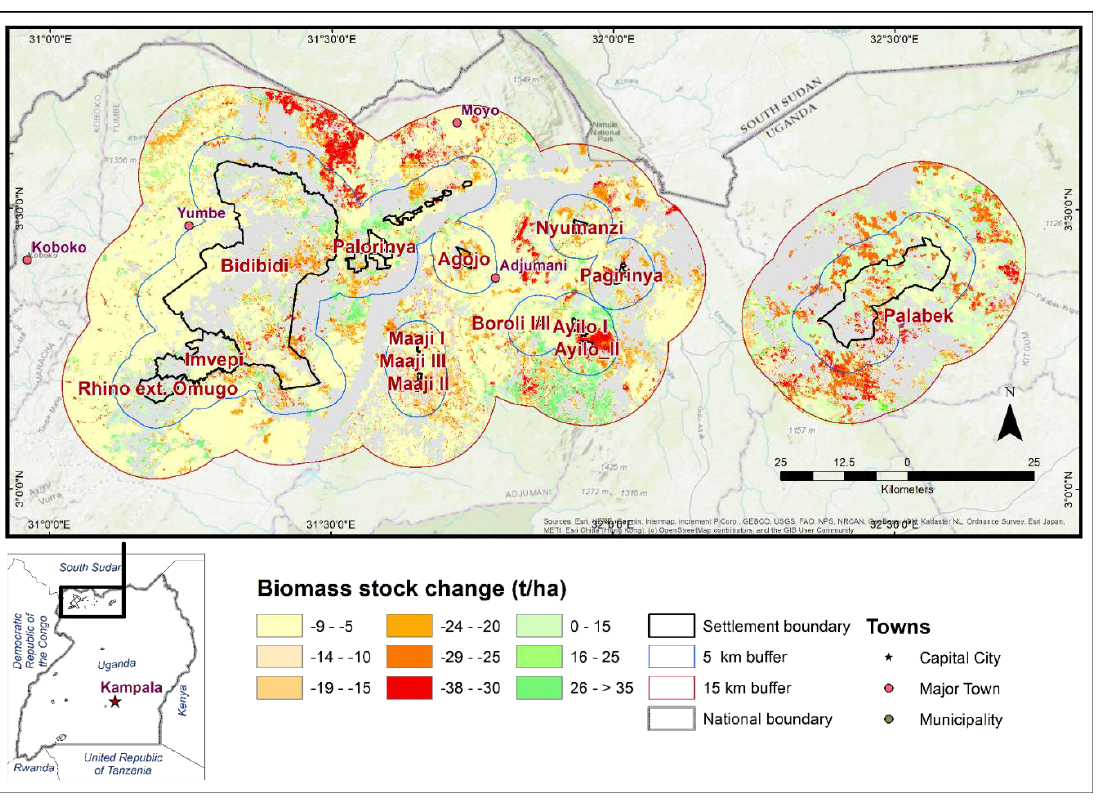
Figure 6. Biomass stock changes between 2013 and 2018 within the AoIs in northern Uganda. Source: World Bank and FAO, 2020a [29].